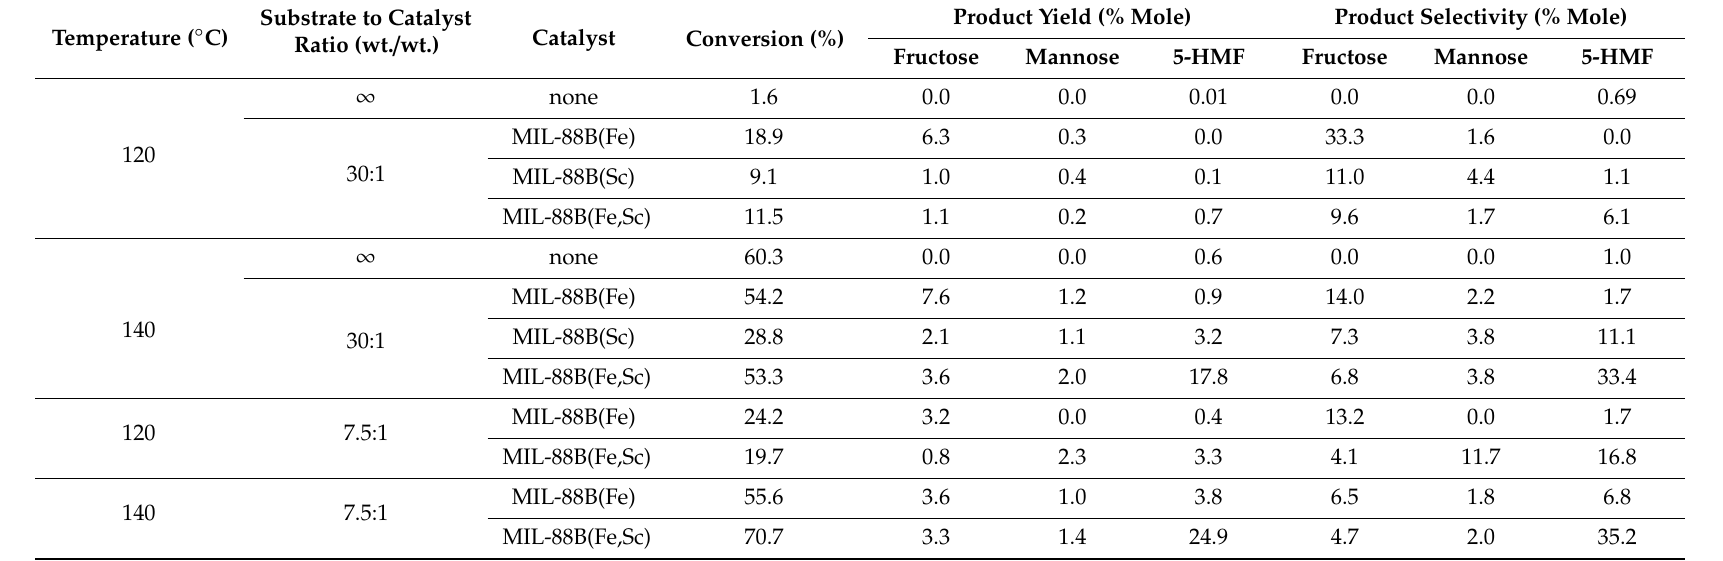
Table 1. Results of catalytic conversion of glucose using MIL-88B catalysts. All reactions were performed in DMSO and the results reported are after 3 hours of reaction time. Product selectivity is defined as 100 × (product yield /